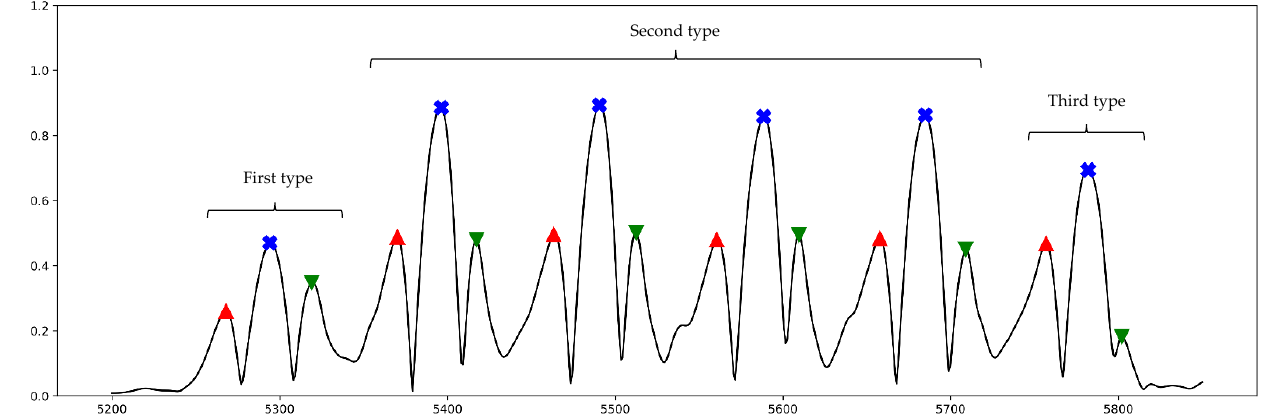
Figure 3. This figure shows three different step types, first step of walking ( first type ), four steps while in steady state ( second type ), and the final step of walking ( third type ). Red markers: FO; blue markers: MidS; green marker: FC. The black line represents the smoothed AngVelMag signal.